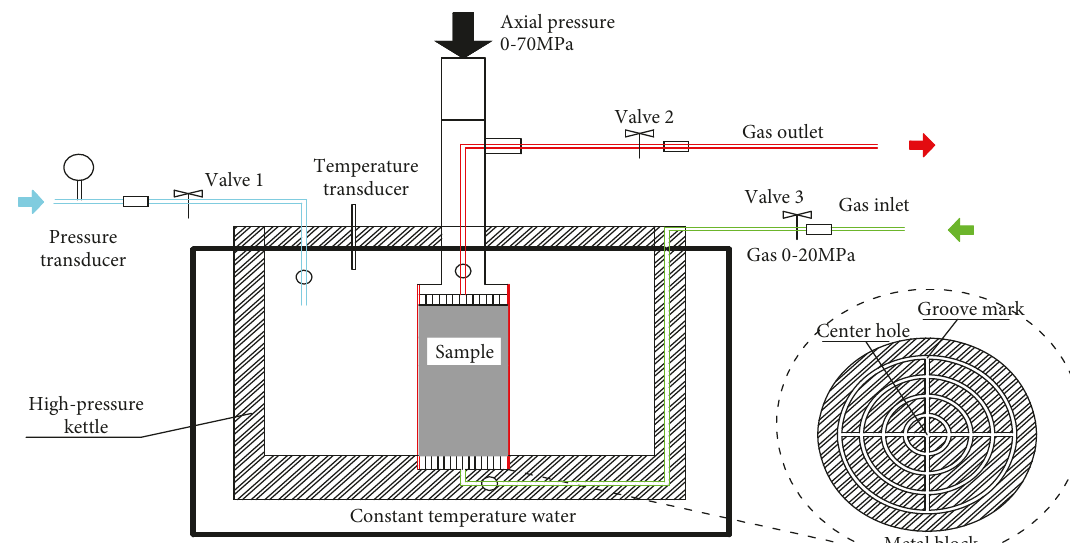
Figure 1: Schematic diagram of the gas fl ow and displacement testing apparatus.